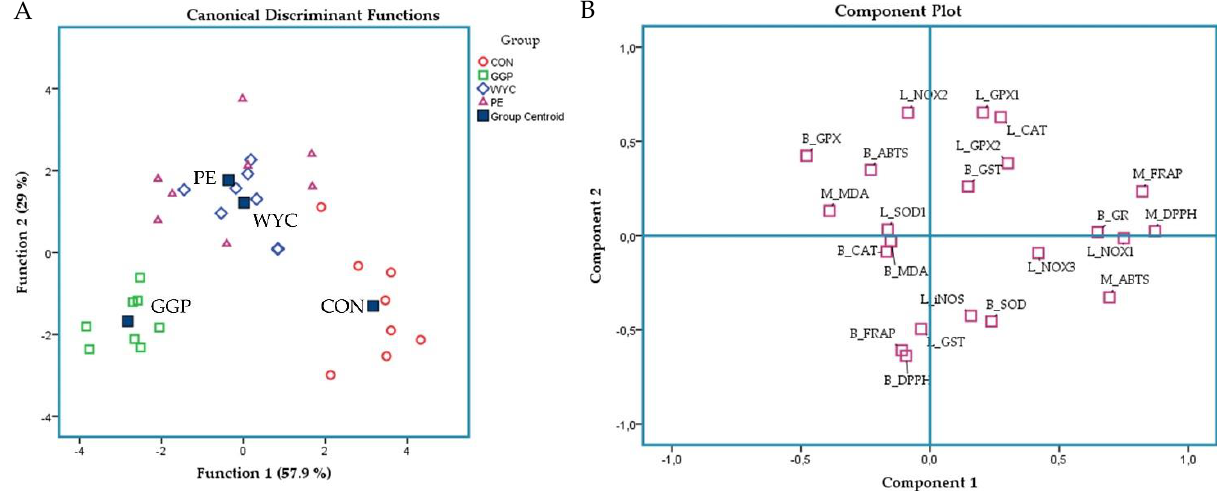
Figure 5. ( A ) Discriminant plots separating the four dietary treatments (Control; CON red, ground grape pomace; GGP green, dried winery yeast cell walls; WYC blue, and phenolic extract from grape stems included in soluble starch; PE purple) according to pooled data of the liver’s relative transcript levels and blood plasma and breast muscle antioxidant indicators. ( B ) Principal component analyses were applied on liver relative transcript levels, blood plasma, and breast muscle antioxidant indicators . L_CAT: catalase relative expression in liver; L_SOD1: superoxide dismutase 1 relative expression in liver; L_GPX1: glutathione peroxidase 1 relative expression in liver; L_GPX2: glutathione peroxidase